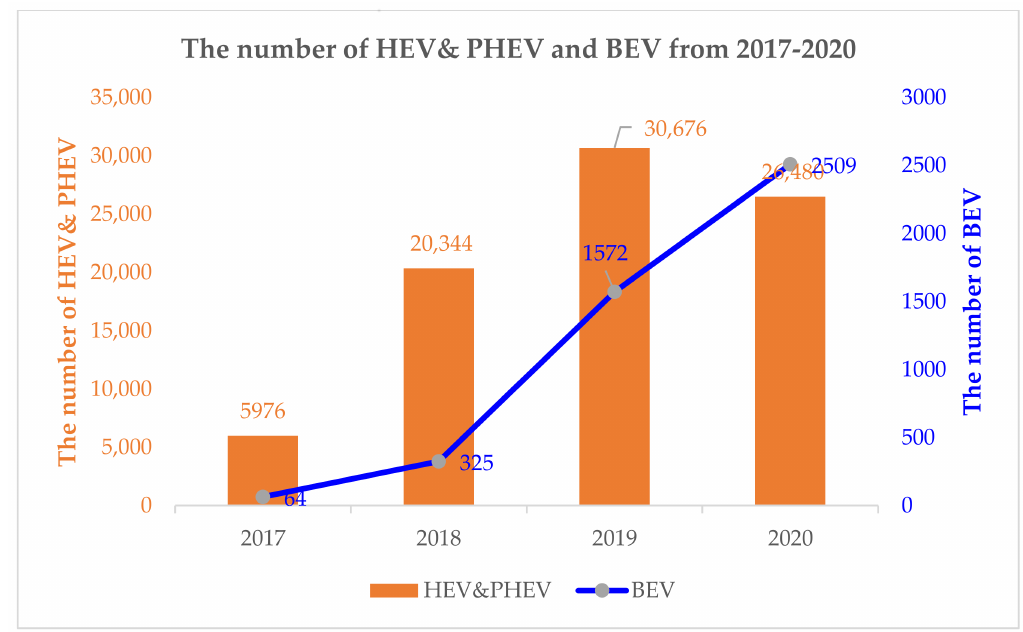
Figure 1. Number of HEV and PHEV and BEV registrations from August, 2017 to October, 2020. Source: Thailand Automotive Institute.